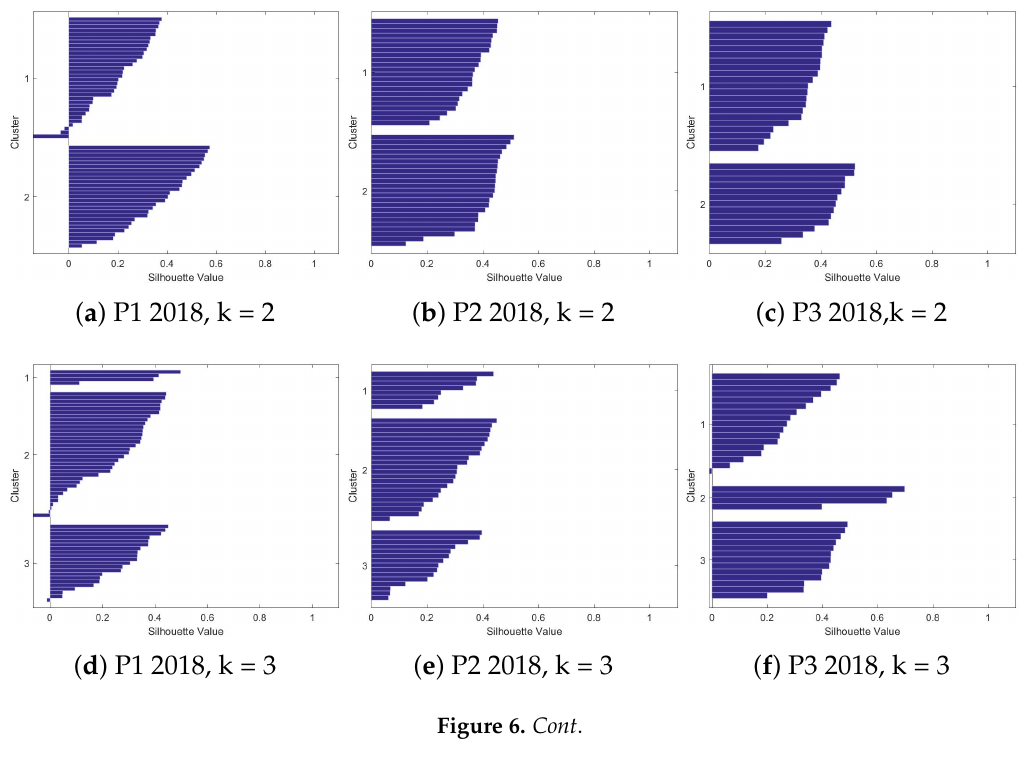
( r ) P3 2018, k = 7 Figure 6. Silhouettes charts for three different times in 2018.